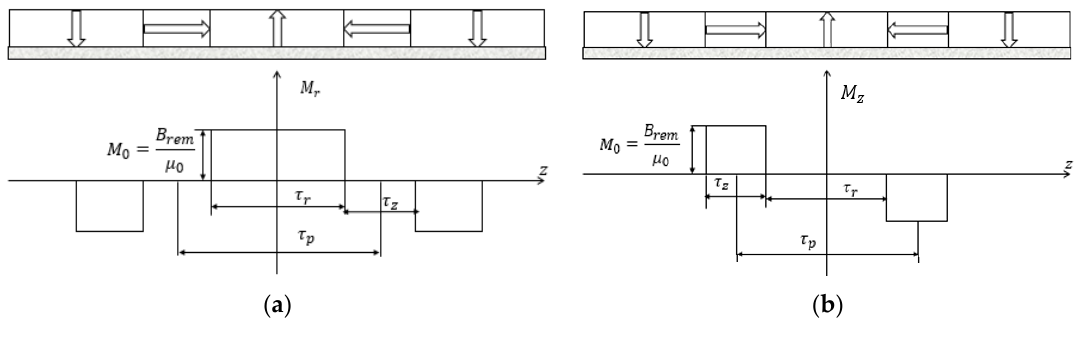
Figure 2. Components of magnetization vector of Halbach layers: ( a ) Radial component; ( b ) Axial component.